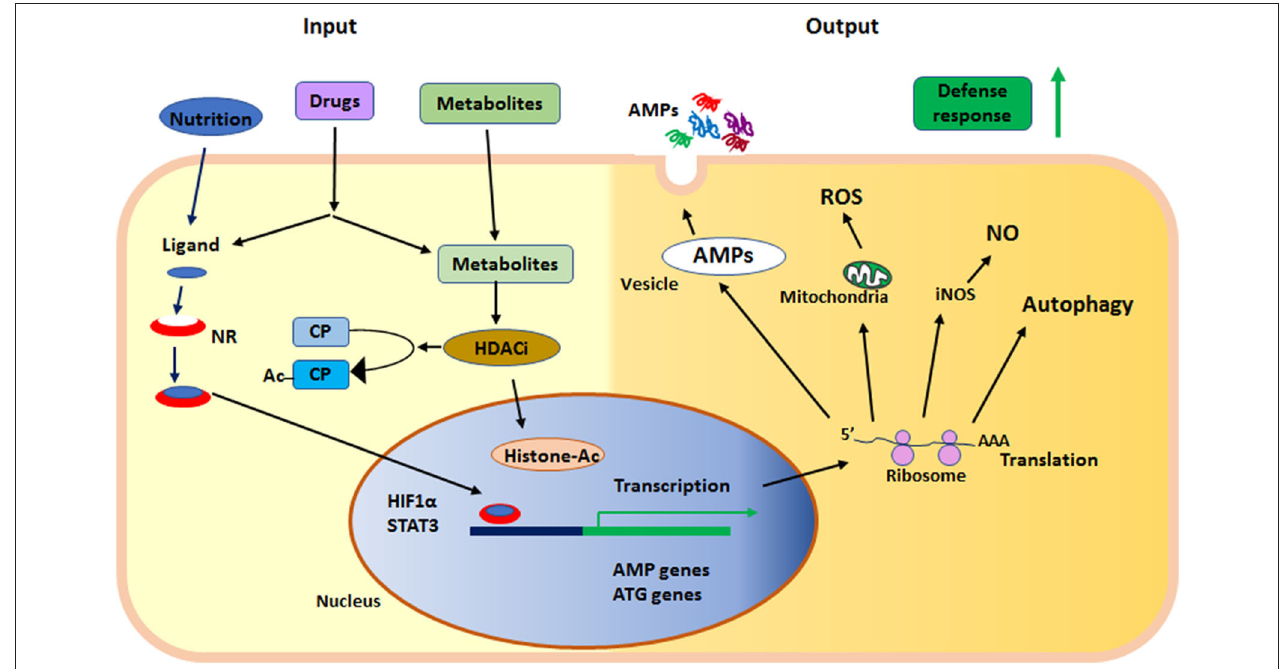
FIGURE 2 | Summary of the main events in early defense by innate effector mechanisms described in the text. NR, nuclear receptor; HDACi, histone deacetylase inhibition; AMPs, anti-microbial peptides; ROS, reactive oxygen species; NO, nitric oxide; iNOS, inducible nitric oxide synthase; ATG, autophagy related gene; HIF1 α , hypoxia-inducible factor 1-alpha; STAT3, signal transducer and activator of transcription 3; CP, cytoplasmic protein; Ac, acetylation; Histone-Ac, acetylated histone and open